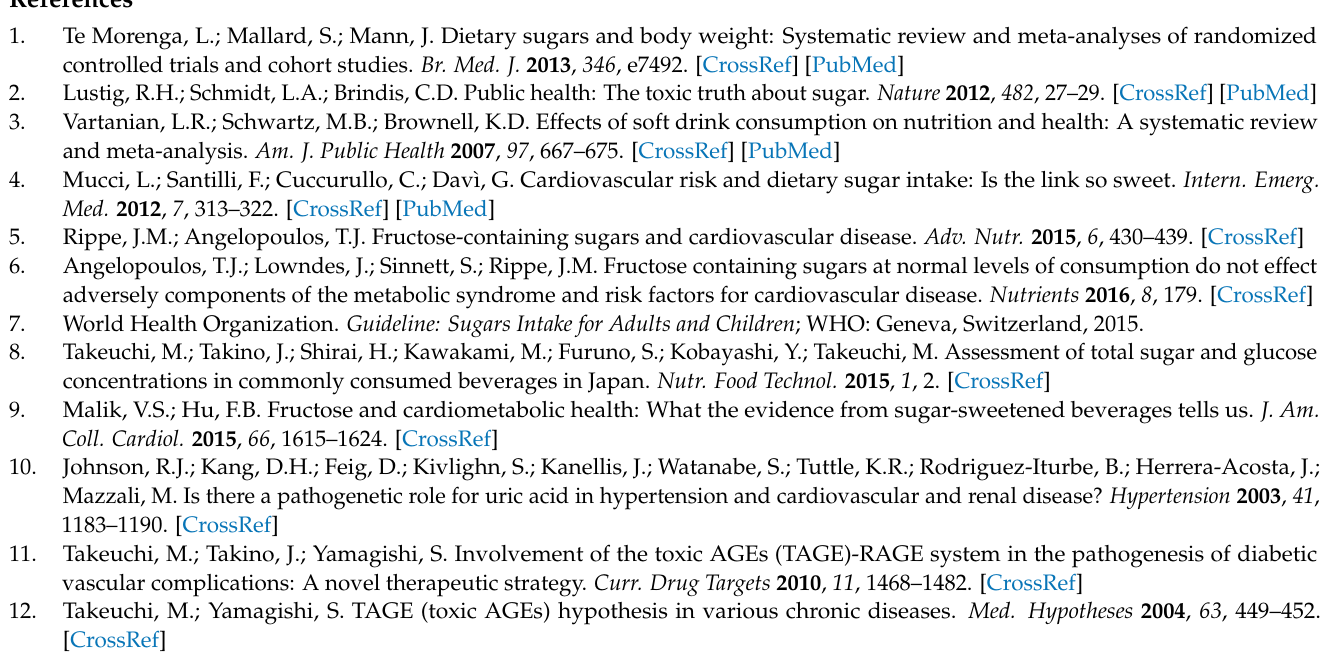
Figure S6: IL-1 β in serum from control and HFCS group rats obtained from animal experiments, Table S1: Body weight, water intake, and urine volume, Table S2: Urinary examination, Table S3: Blood